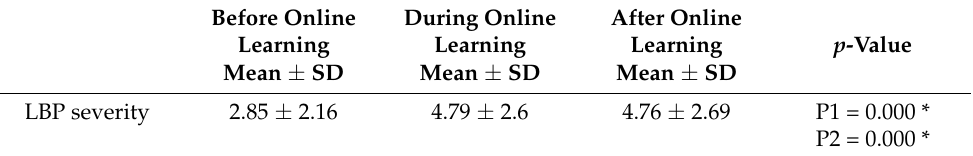
Table 4. Low back pain severity before, during, and after online distance learning.